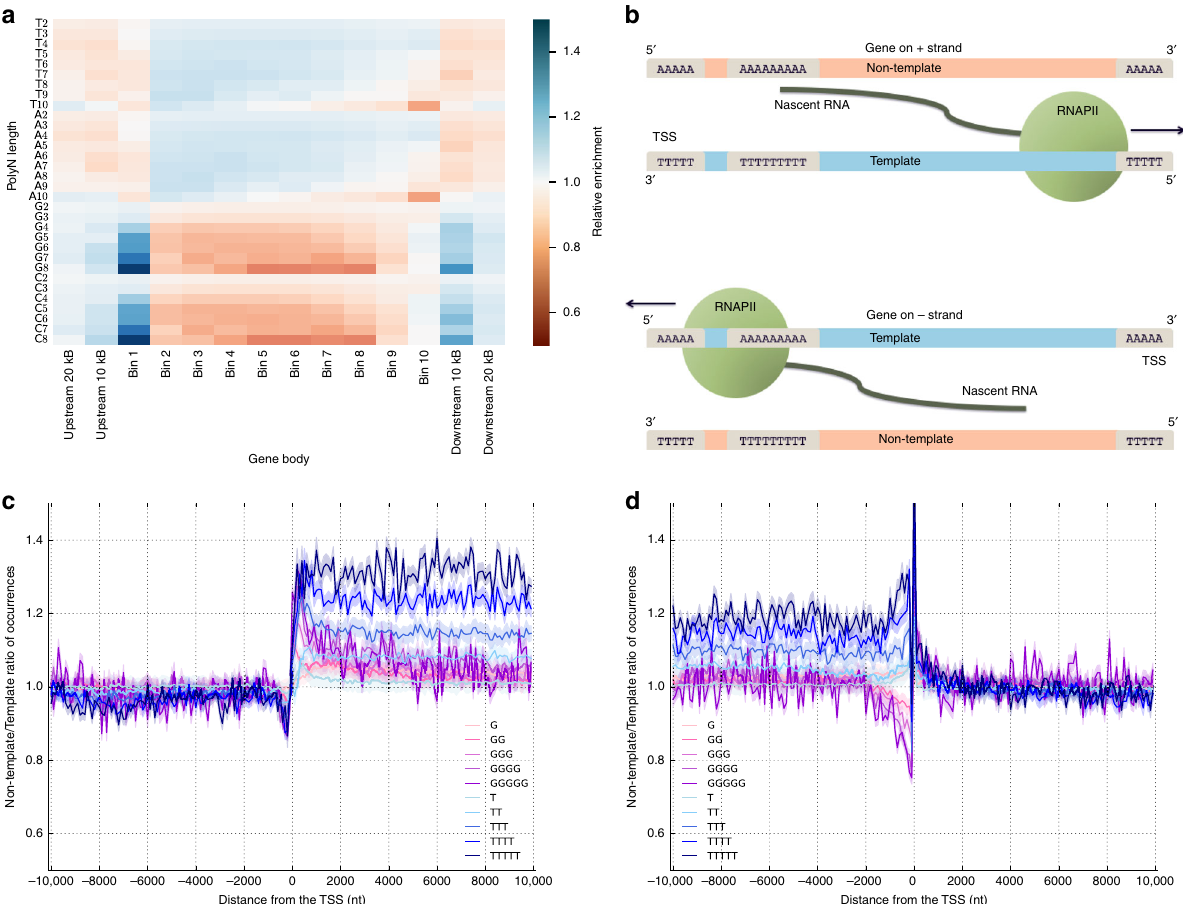
Fig. 2 Strand asymmetries of polynucleotide (polyN) repeat tracts within transcribed regions. a Enrichment of various polyN motifs across genes. Each gene is divided into ten bins, and two additional bins are added at either end of each gene. For any given bin, blue indicates relative enrichment in comparison to all other bins for that polyN, whereas red indicates relative depletion. b Scheme depicting the identi fi cation of polyN motifs on the template (blue) or non-template (orange) strands, dependent on the direction of the gene. RNA-polymerase II (RNAPII) binds to the template strand and mediates transcription. Thus, in the panel above, where the gene is on the ( + ) strand, the polyA tracts are on the non-template strand. In the panel below, where the gene is on the ( − ) strand, the polyA tracts are on the template strand. c Density of polyT and polyG motifs around the transcription start site (TSS). The gradient of pink to purple represents polyG tracts of 1-5 bp length, whereas the gradient of light blue to dark blue represents polyT tracts of 1 – 5 bp length. Error bars represent standard error from 1000-fold bootstrapping. d Density of polyT and polyG motifs around the transcription end site (TES). Error bars represent standard error from 1000-fold